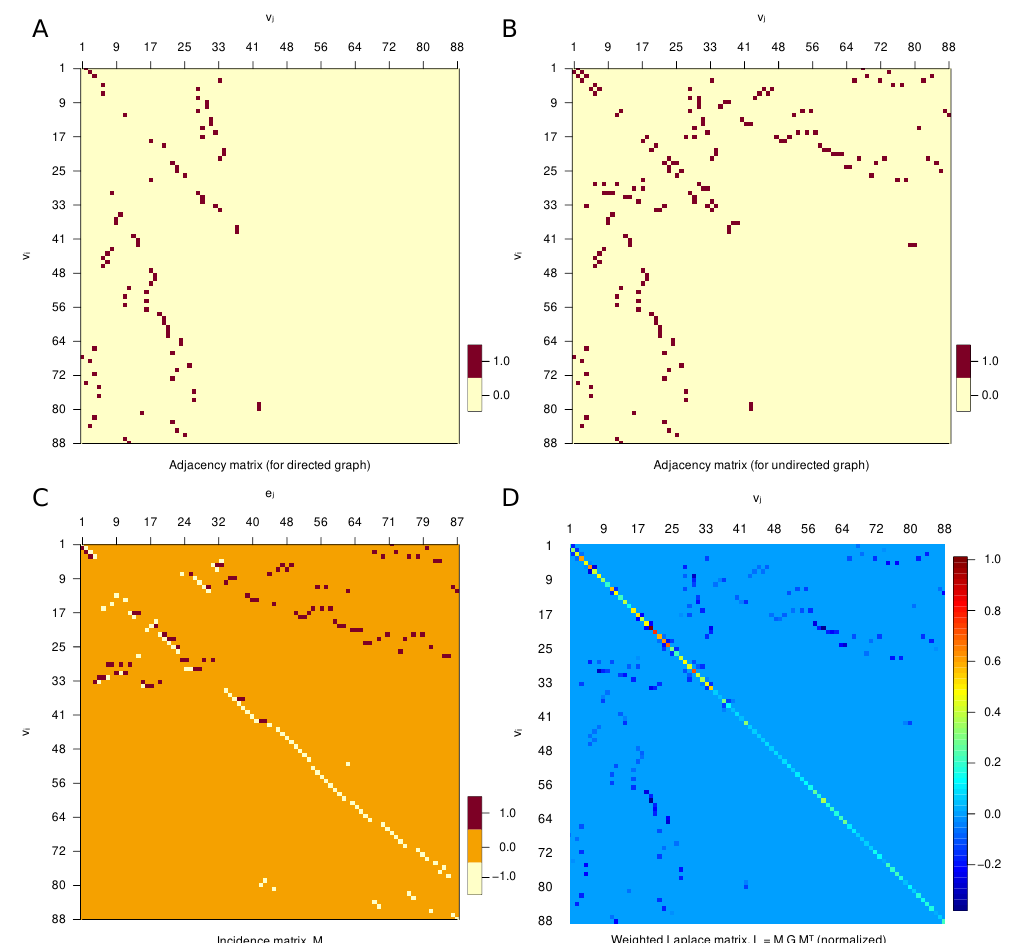
Figure 2. Matrix representation of the anatomy-based graph of murine lymphatic system presented in Figure 1. The i -th and j -th vertices and edges are denoted as v i , v j and e i , e j , respectively. ( A , B ) Ad- jacency matrix A (for oriented and simple graph). ( C ) Incidence matrix, M . ( D ) Weighted Laplacian matrix, L = MGM T , normalized by the maximum matrix element. The conductance matrix G for constant vessel diameters is used for the